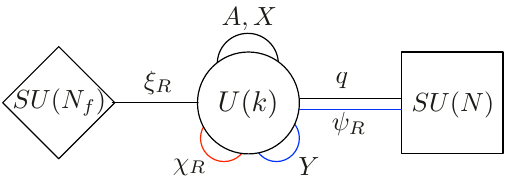
Figure 4 . The 1d N = (0 ; 4) theory for the 5d SU( N ) with two anisymmetrics and N